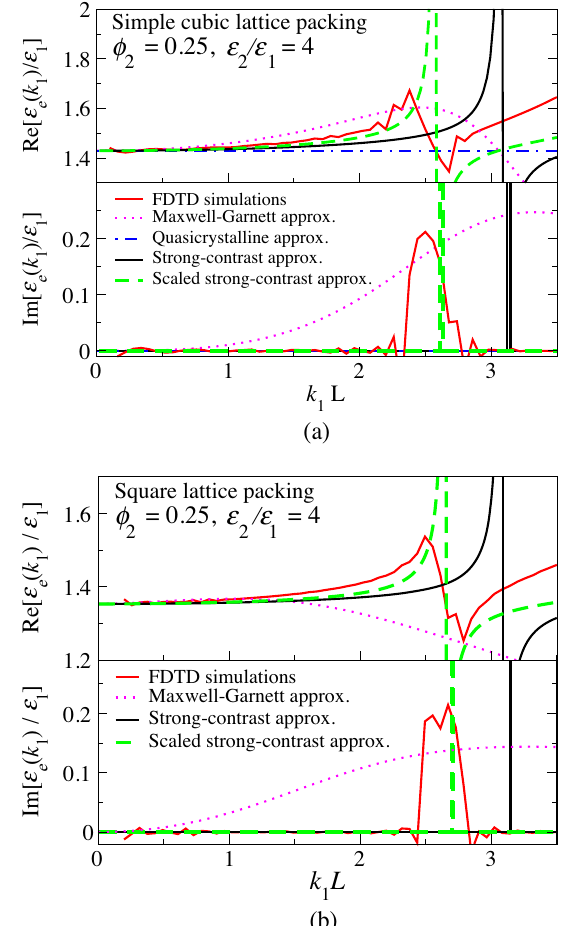
FIG. 8. Comparison of the predictions of the strong-contrast formulas Eqs. (67) and (73) to the Maxwell-Garnett [Eqs. (17) and (16)] and QCA (18) approximations for the effective dynamic k dielectric constant ε 1 Þ as a function of the dimensionless wave e ð number k 1 L of periodic packings to our corresponding computer simulation results. We consider (a) 3D simple cubic lattice and (b) 2D square lattice of packing fraction ϕ 2 ¼ 0 . 25 and contrast ratio ε 2 = ε 1 ¼ 4 . Here, k 1 is the wave number in the reference (matrix) phase along the Γ - X direction, and L is the side length of a unit